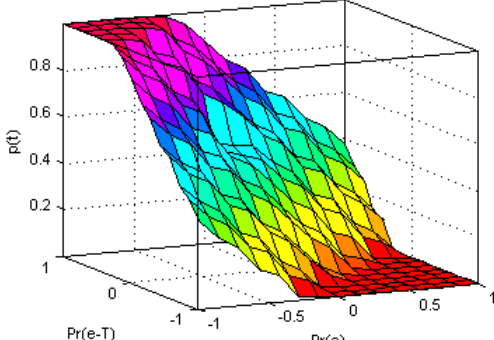
Figure 10. The deductive surface of the FLREM mechanism